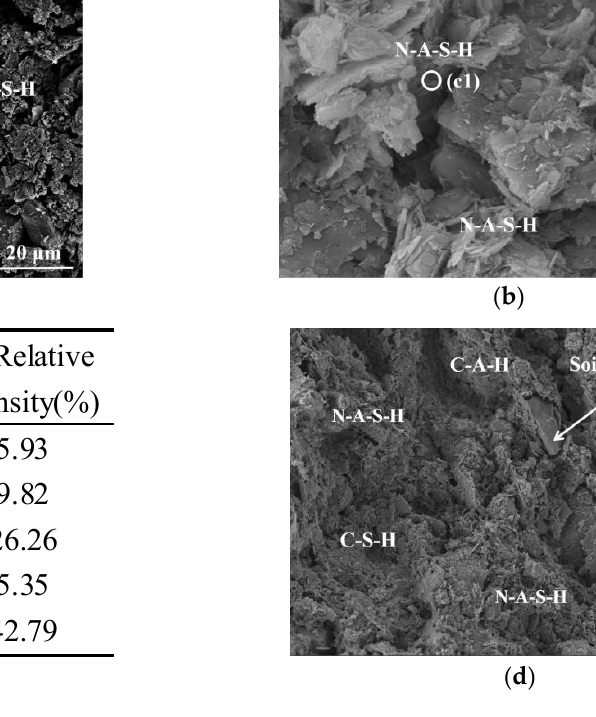
Figure 8. SEM images of II-5: ( a ) and ( b ) 7 d; ( c ) EDS result—7 d; ( d ) 28 d.